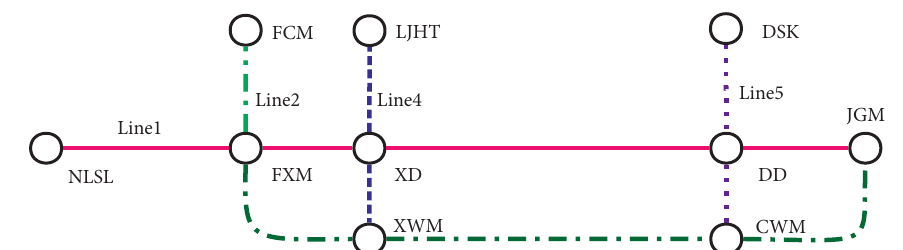
Figure 1: Partial diagram of Beijing Subway network.